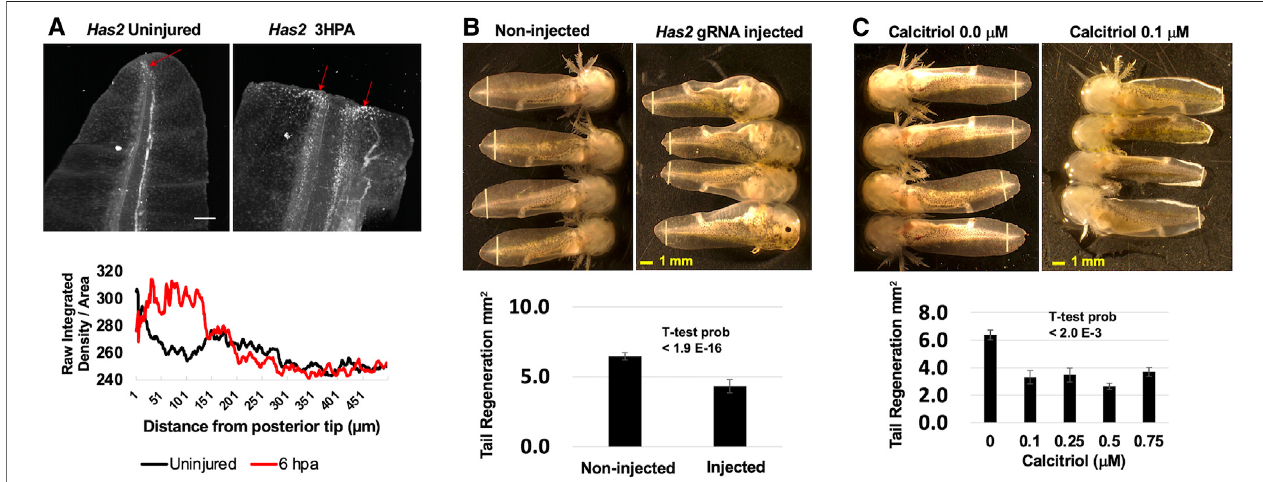
FIGURE3| Functionalanalysisof Has2 . (A) Has2 expressionincreasedaftertailamputationandwashighestnearthemiddleofthetailandattheamputationplane where the blastema subsequently forms. The red arrows indicate Has2 positive cells and the scale bar is 250 μ m. (B) CRISPR-Cas9 and gRNAs targeting Has2 were injected into embryos. Injected and non-injected embryos were reared to developmental stage 42 and tails were amputated. Injected embryos presented enlarged hearts, edema, and little to know vasculature. At 7 DPA, on-injected embryos regenerated signi fi cantly more tail tissue than injected embryos. The yellow vertical lines indicate the plane of amputation. (C) Developmental stage 42 embryos were administered DMSO or hyaluronan synthase inhibitor calcitriol after tail amputation. Calcitriol-treated embryos presented white patches on their gills and tail fi ns. At 7 DPA, DMSO-treated embryos regenerated signi fi cantly more tail tissue than calcitriol- treated embryos. The yellow vertical lines indicate the plane of